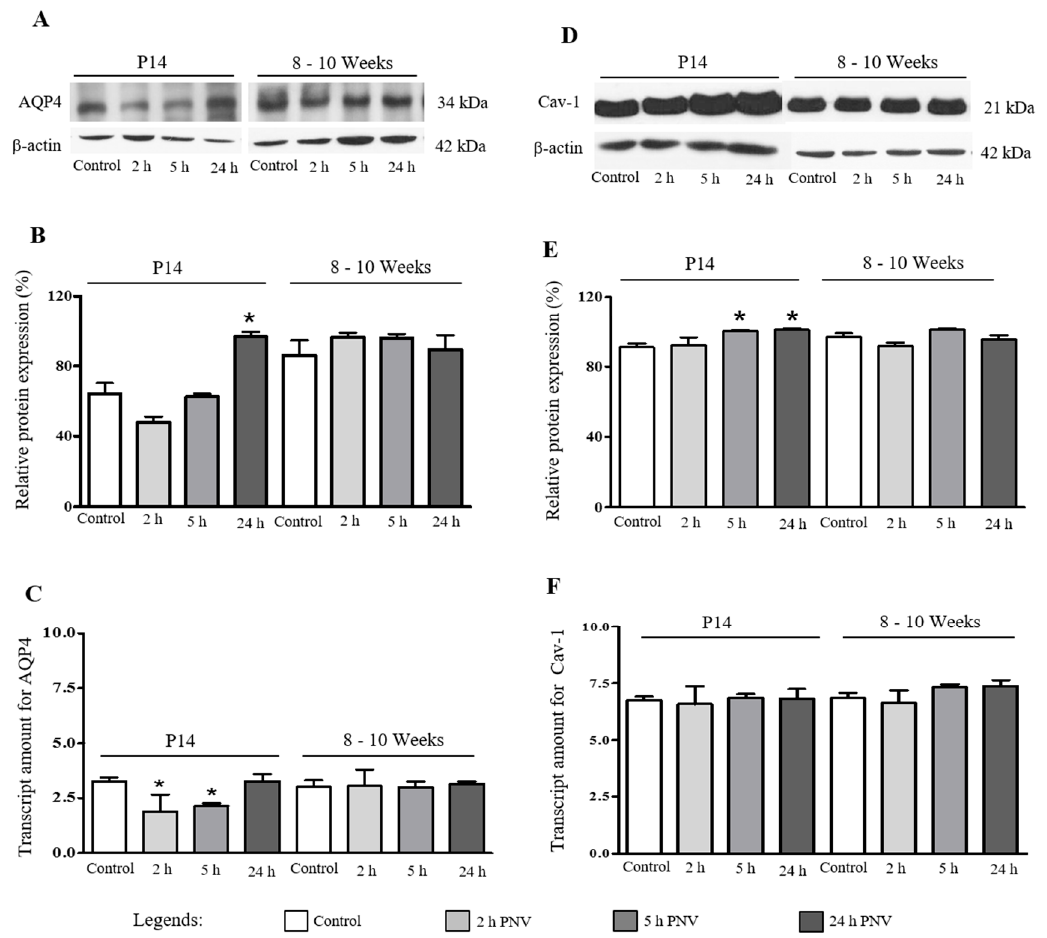
Figure 1. Expression of aquaporin (AQP4) and caveolin-1 (Cav-1) in hippocampus of 14-day-old and 8–10 weeks-old rats after 2, 5, and 24 h of 0.9% saline (control) or Phoneutria nigriventer venom (PNV) (1.7 mg/kg) i.p injection. ( A , D ) Representative Western blots for AQP4, Cav-1, and β -actin expression (endogenous control); ( B , E ) Graphic of Western Blotting for AQP4 and Cav-1. The results were shown as percentage of control (100%); ( C , F ) AQP4 and Cav-1 mRNA levels measured by qPCR were normalized by using GADPH as endogenous control. * p < 0.05 compared to the respective control (Student’s t -test of data expressed as mean ± SEM); n = 5/time point.